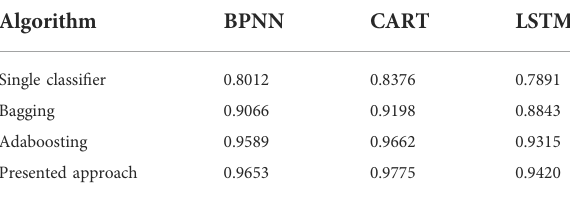
TABLE 5 omparisons of the accuracy of different ensemble learning strategies.